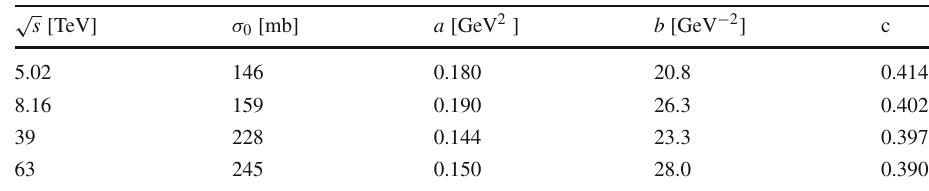
Table 1 The parameters of the one channel eikonal description of nucleon–nucleon amplitude, described in the text